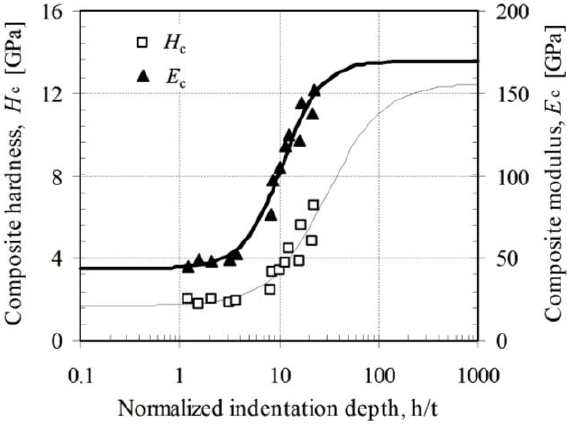
Figure 6. Example of film modulus and hardness fitting on experimental data of (ZrO 2 -MMT) 30 annealed at 600 °C with clay montmorillonite 0.4 wt %. Fitted E f = 43.75 ± 4.86 GPa, E s = 169.60 ± 7.83 GPa, H f = 1.68 ± 0.36 GPa, and H s = 12.50 ± 0.56 GPa.